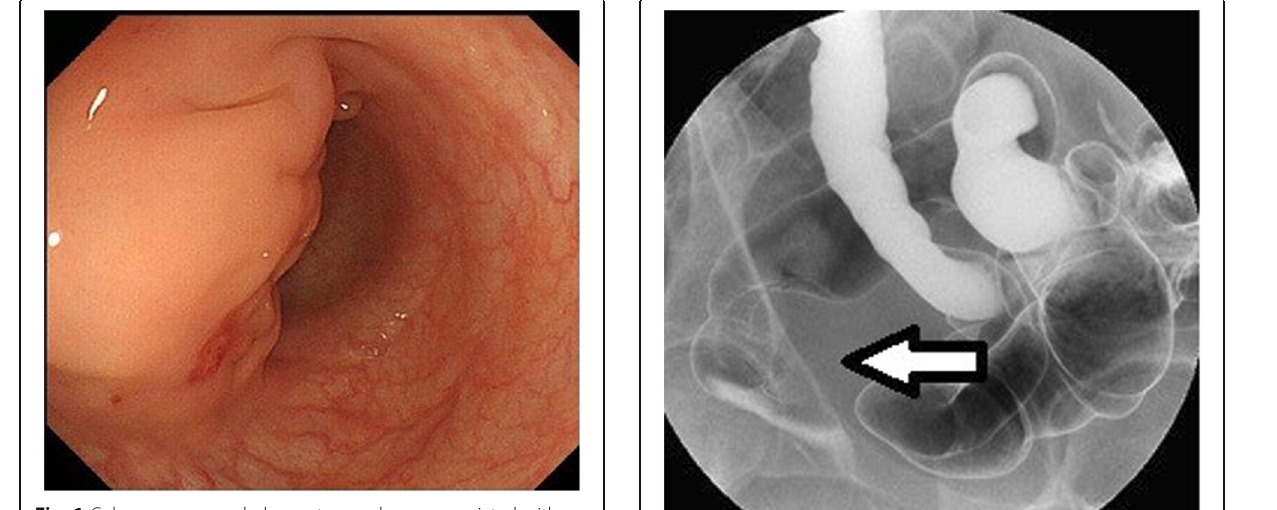
Fig. 1 Colonoscopy revealed an extramural mass associated with the sigmoid colon